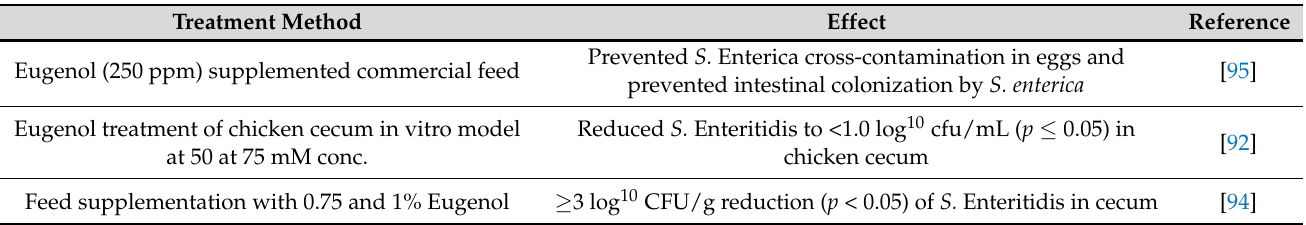
Figure 2. Effect of Eugenol supplementation in controlling Salmonella colonization in chickens and its spread. Created with BioRender.com. spread. Created with BioRender.com, 5 December 2022. Table 1. Effect of Eugenol supplementation on containing Salmonella colonization in chickens and